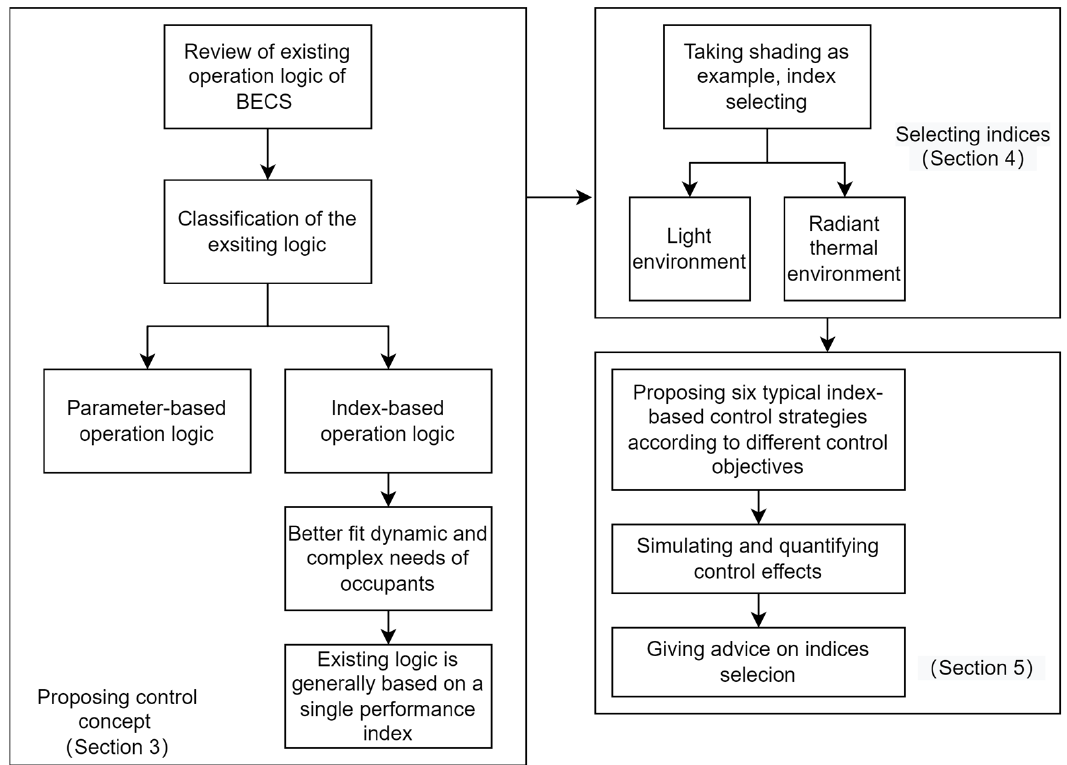
Figure 2. Flowchart of this study.